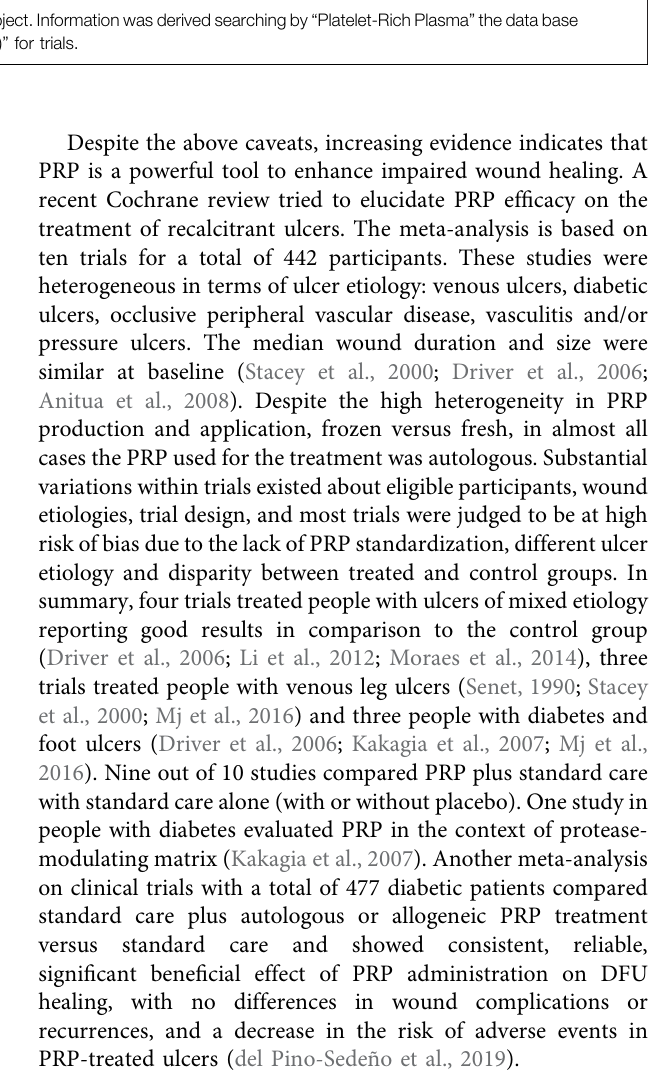
Frontiers in Bioengineering and Biotechnology |